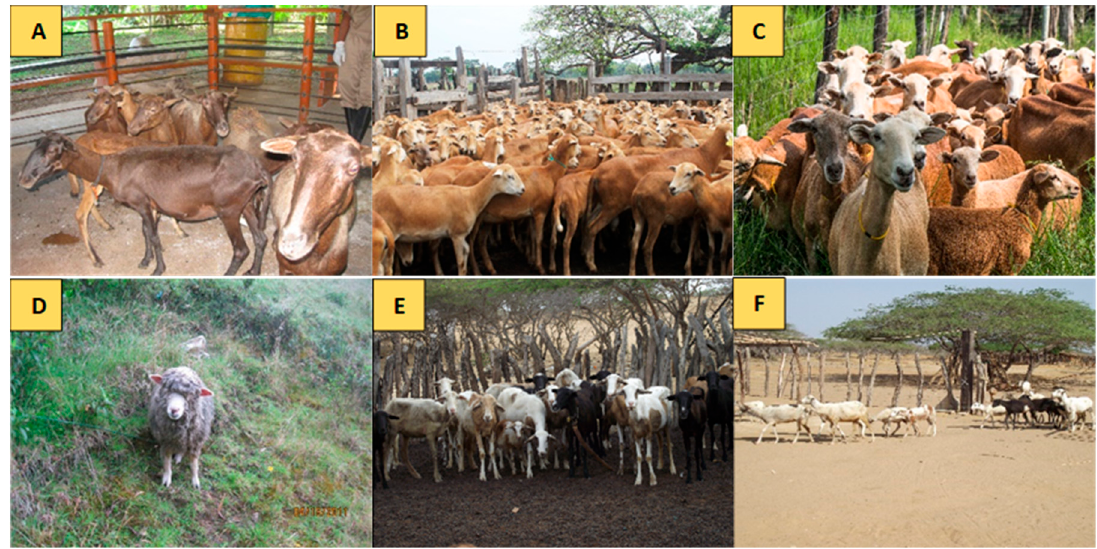
Figure 1. Five breeds of Colombian Creole sheep analyzed in the study. ( A ) Ethiopian (OPC E ); ( B ) Sudan (OPC S ); ( C ) Pelibuey (OPC P ); ( D ) wool Creole sheep (CL); ( E , F ) Wayúu Creole sheep (OPC W ).